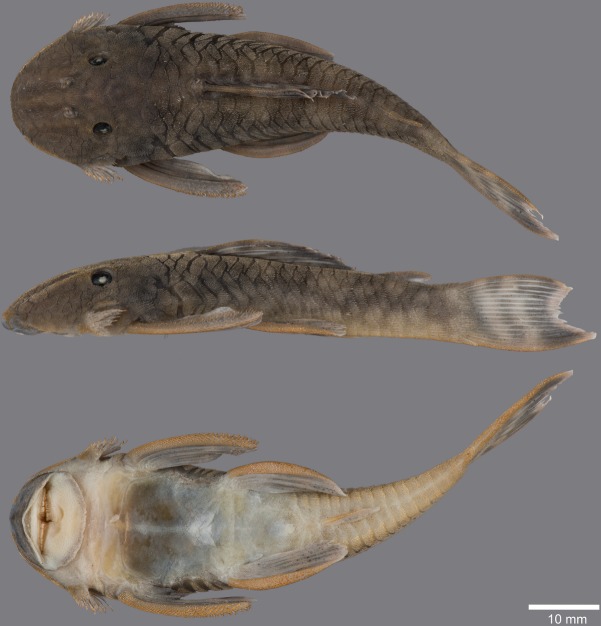
Guyanancistrus brownsbergensis.MHNG 2745.065 (JM14 01), holotype; Suriname: 63.8 mm SL; Suriname: Brokopondo: Kumbu Creek, Saramacca River Basin.